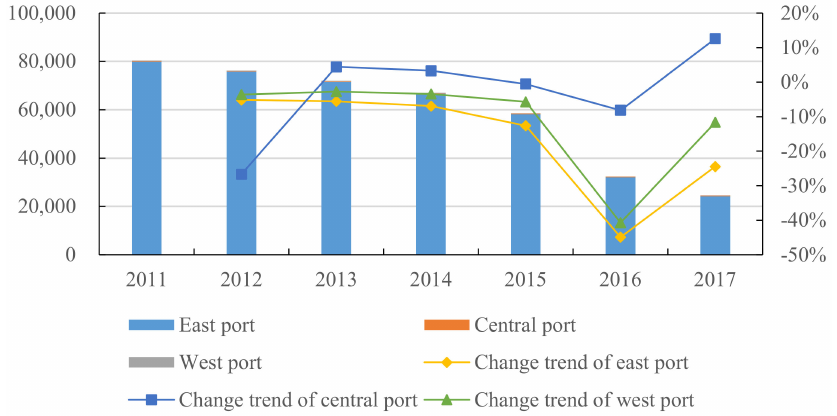
Figure 3. SO 2 emissions from the eastern, central and western ports (unit: ton).